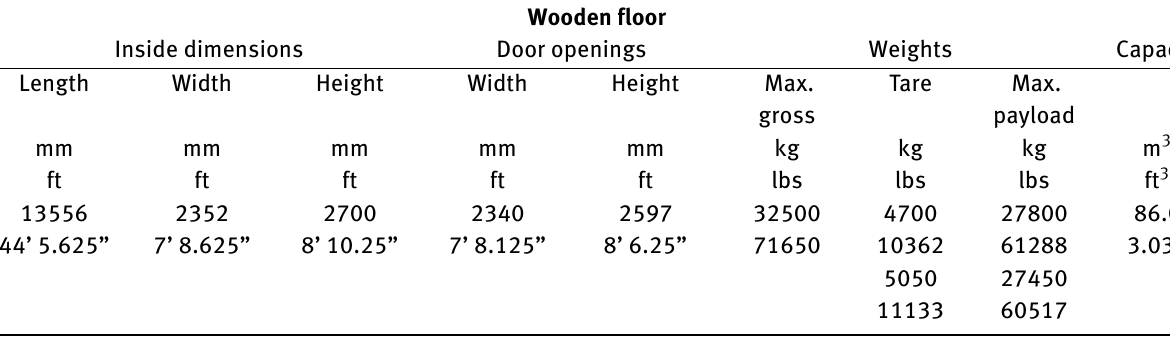
Table 1: High cube general purpose container 45’